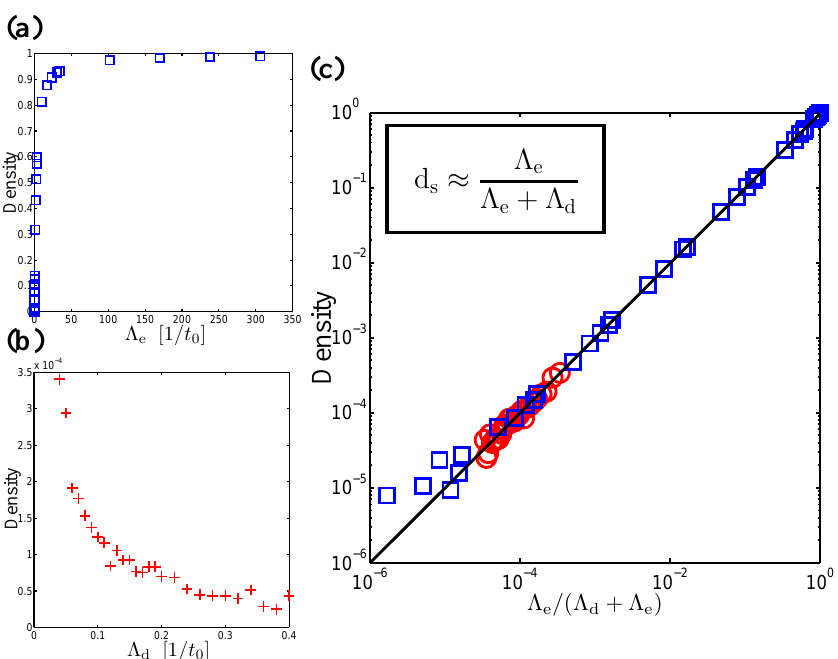
Fig. 8. Relation between the density of mobile sedimentary cells and the rate parameters of the cellular automaton model. (a) Density of mobile sedimentary cells with respect to 3 e for 3 d t 0 = 2 (b) Density of mobile sedimentary cells with respect to 3 d for 3 e t 0 = 4 × 10 − 5 . (c) Density of mobile sedimentary cells with respect to 3 e /(3 e + 3 d ) : 3 d t 0 = 2 (blue squares), 3 e t 0 = 4 × 10 − 5 (red